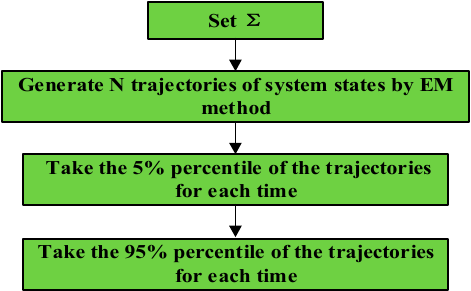
Figure 5. The Monte Carlo simulation process. EM: Euler-Maruyama.